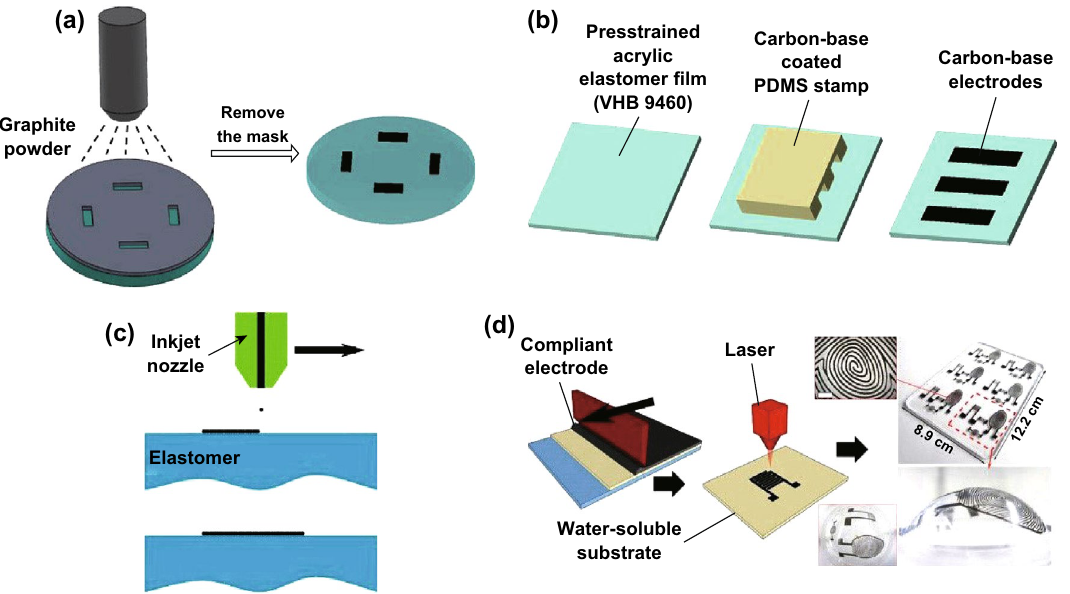
Fig. 1 The techniques for creating carbon-based compliant electrodes. a Shadow masking: using a shadow mask to selectively spray the carbon material on target area and then removing the mask to get the final electrodes. b Stamping process: using patterned elastomeric stamp to pick up the carbon material and stamping it on the DEM. Redrawn from Ref. [56] with permission. c Printing: the carbon-based materials can be made into conductive ink; then using printing technology to pattern electrodes. Adapted from Ref. [51] with permission. d Laser ablation: the thick PDMS–carbon composite layers can be patterned by laser ablation and bonded to PDMS membrane by oxygen plasma activation. Adapted from Ref. [58] with